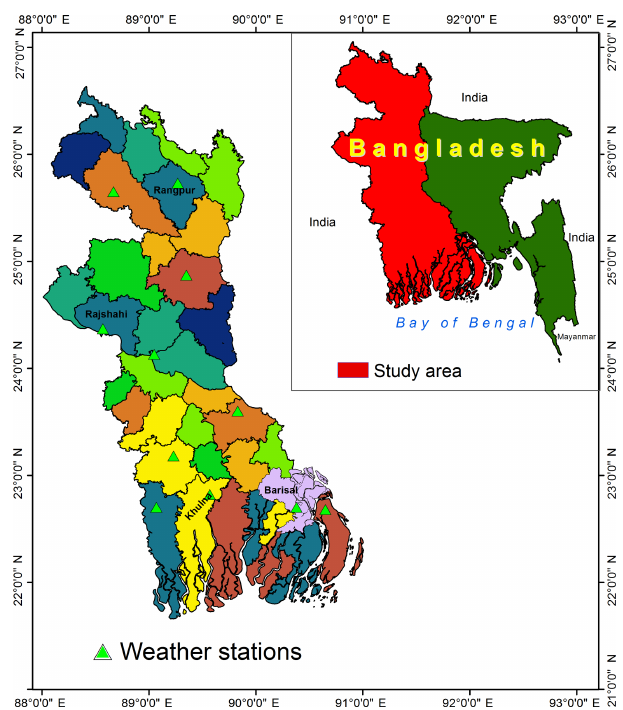
Figure 1. Study area in the western part of Bangladesh with loca- tions of meteorological